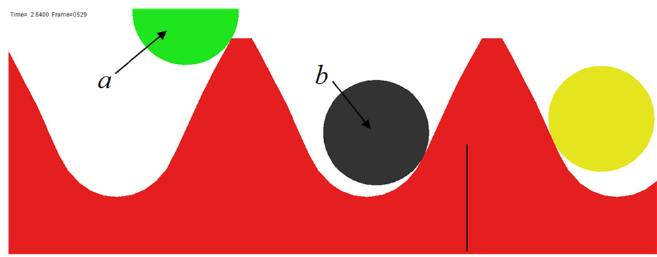
Figure 13. Simulation result of point 5.